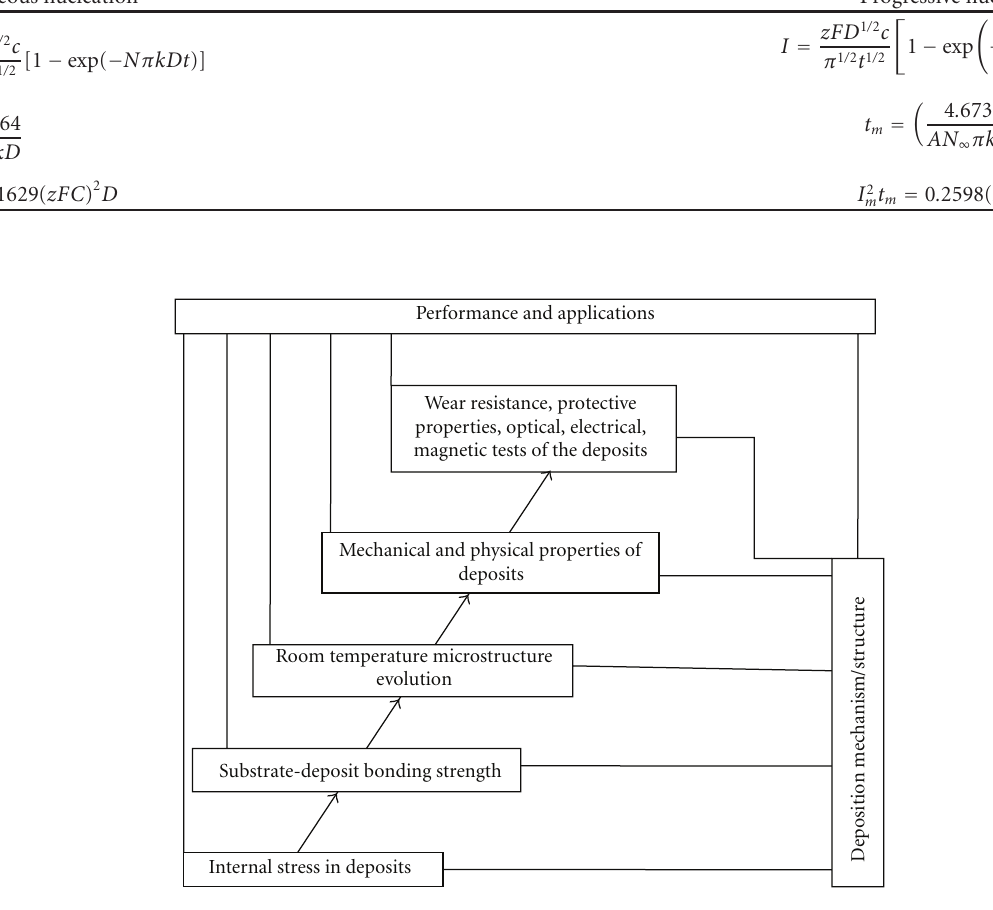
Figure 12: Scheme of complex studies of the base metal-coating